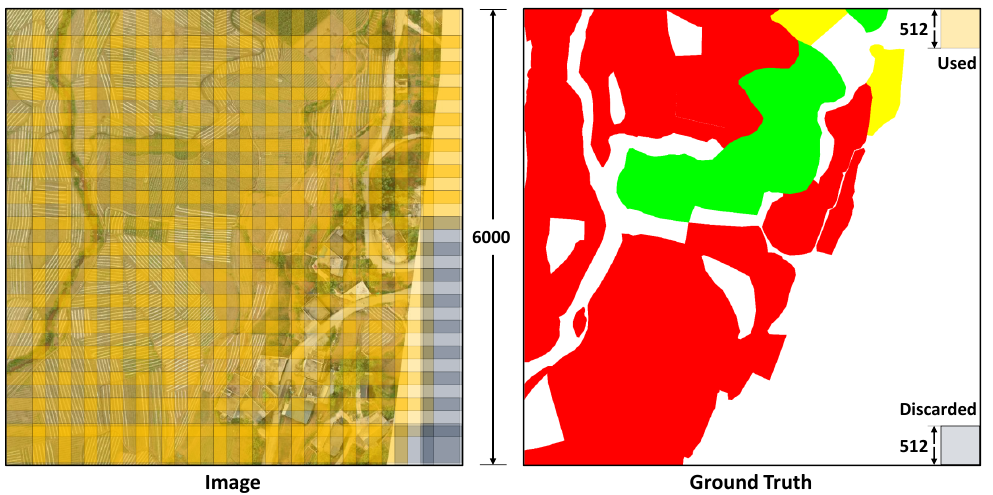
Figure 11. Overlapping sliding window